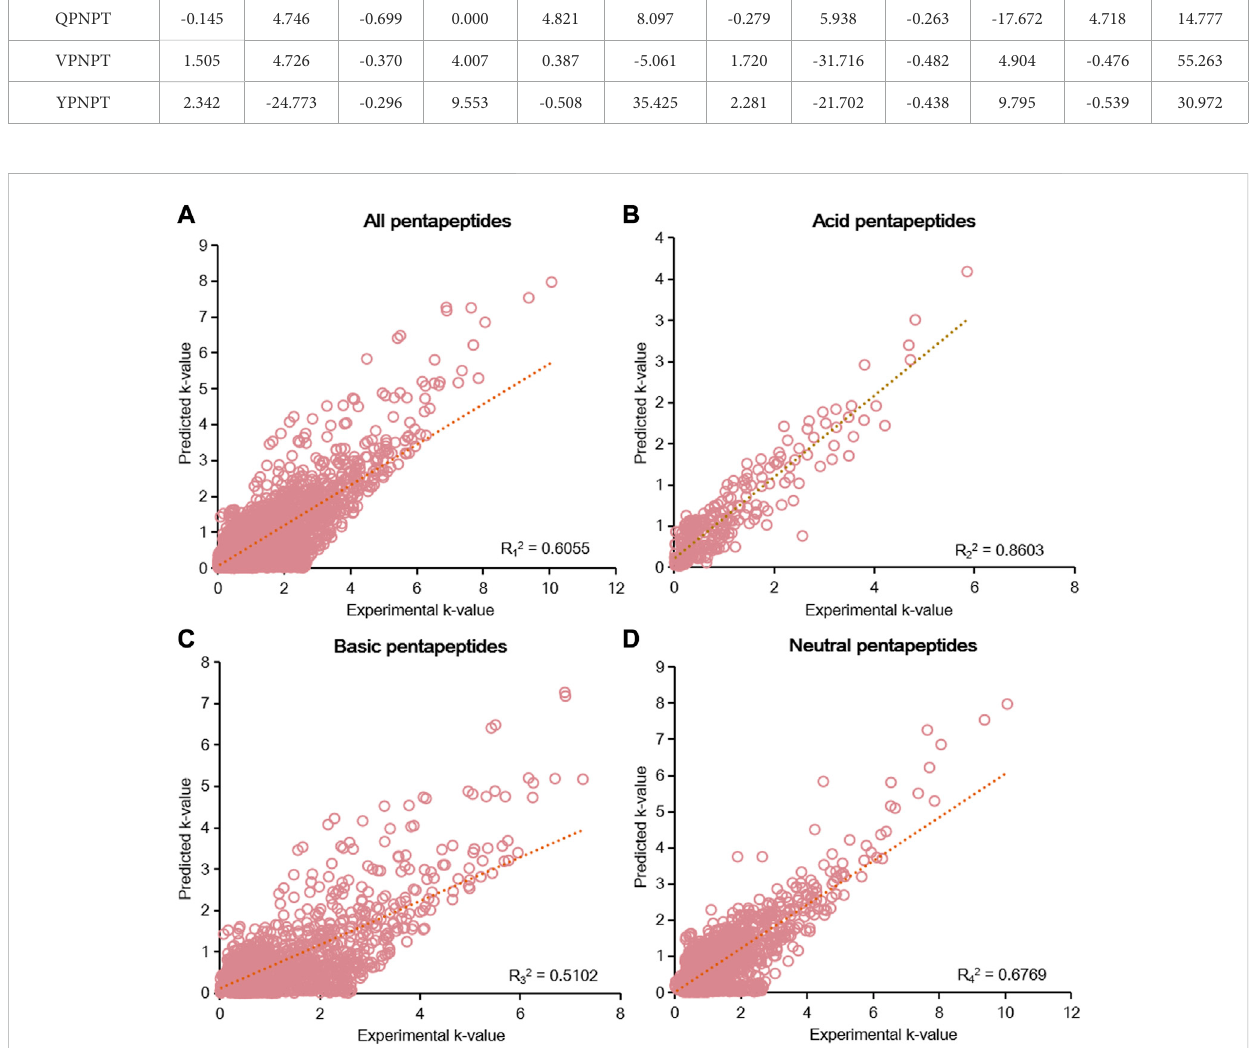
FIGURE 4 Linear fi tting resultsofthepredictedk-valueand experimentalk-value forall pentapeptides (A) , acidpentapeptides (B) , basicpentapeptides (C) ,and neutral pentapeptides (D) in the six-parameter model of T and